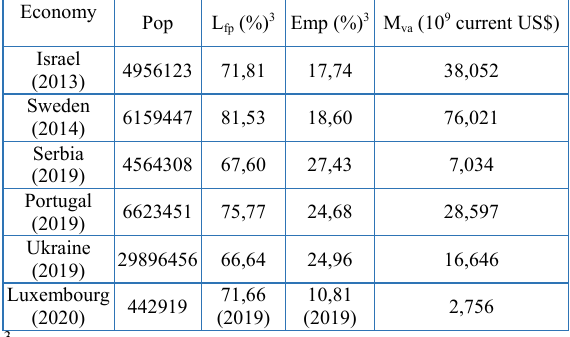
Table 6. Data to computation of value added per worker.